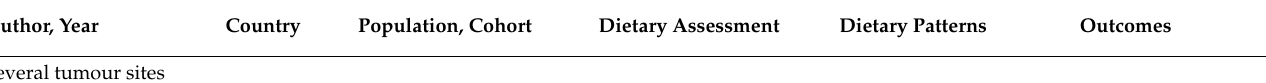
Table 1. Characteristics of the included prospective cohort studies ( n = 35) examining the association between dietary patterns and prognosis in cancer